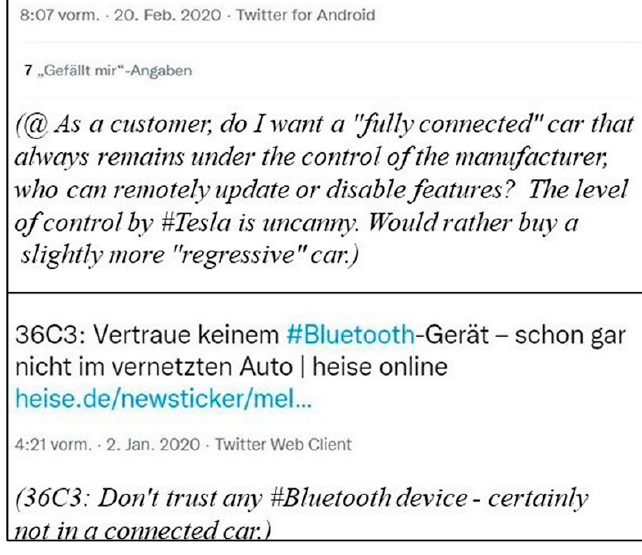
Figure 11. Skeptical and negative statements about personal data.